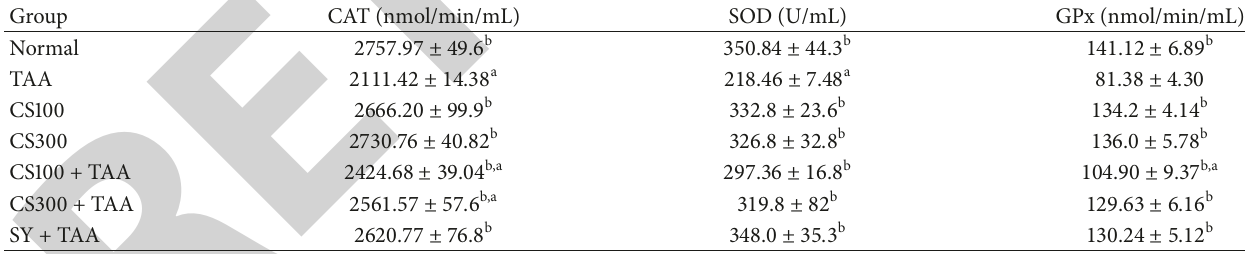
Table 3: Effect of TAA, SY, and CS ethanolic extracts intake on some in vivo antioxidant parameters in TAA-induced liver cirrhosis in rats. Group